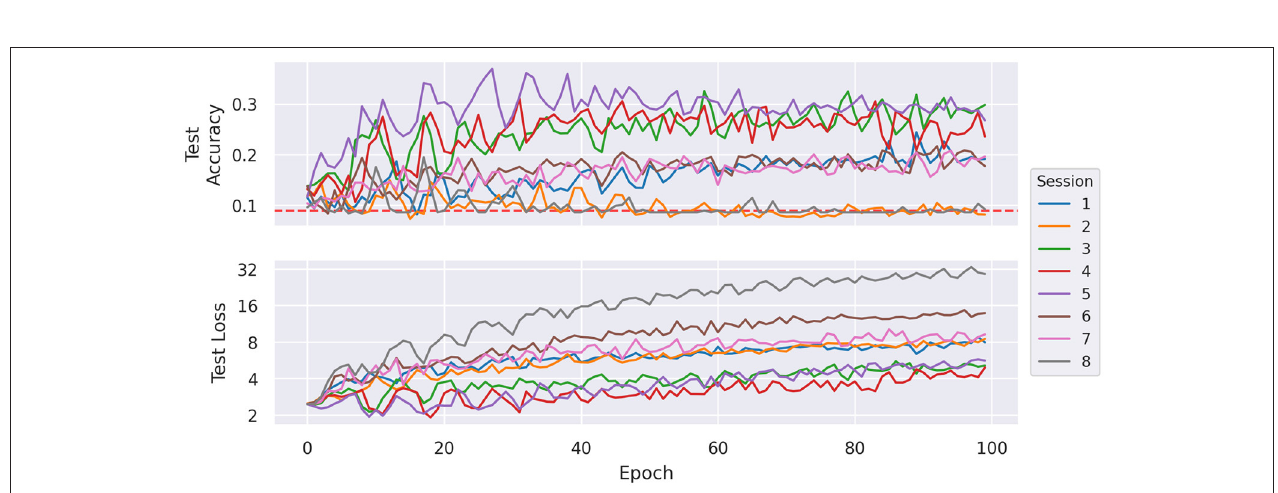
FIGURE 7 | Average test accuracy and (sparse) cross-entropy loss per training epoch of MLP 2 Unreg by holdout session. The dashed red line indicates the accuracy of a uniform random